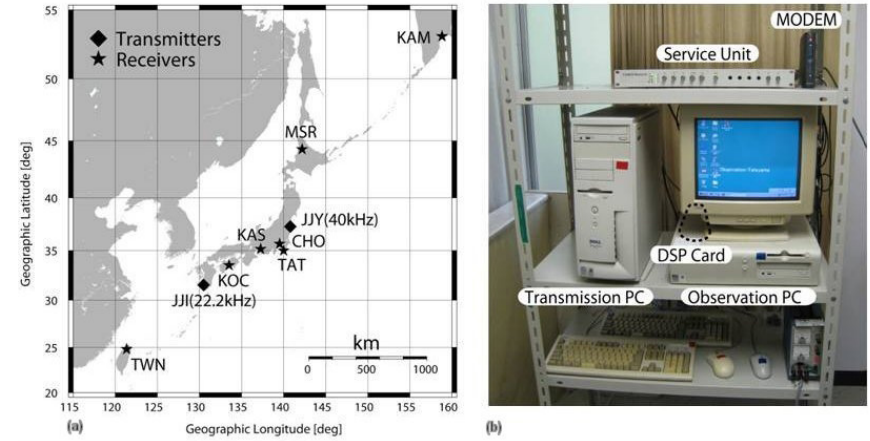
Fig. 1. (a) Pacific VLF radio network. The receivers (OmniPal) are marked by stars and five are located in Japan, one in Kamchatka (Russia), and one in Taiwan. The signals collected come from JJY (40kHz) and JJI (22.2kHz) transmitters located in Japan. (b) The OmniPal recording system.